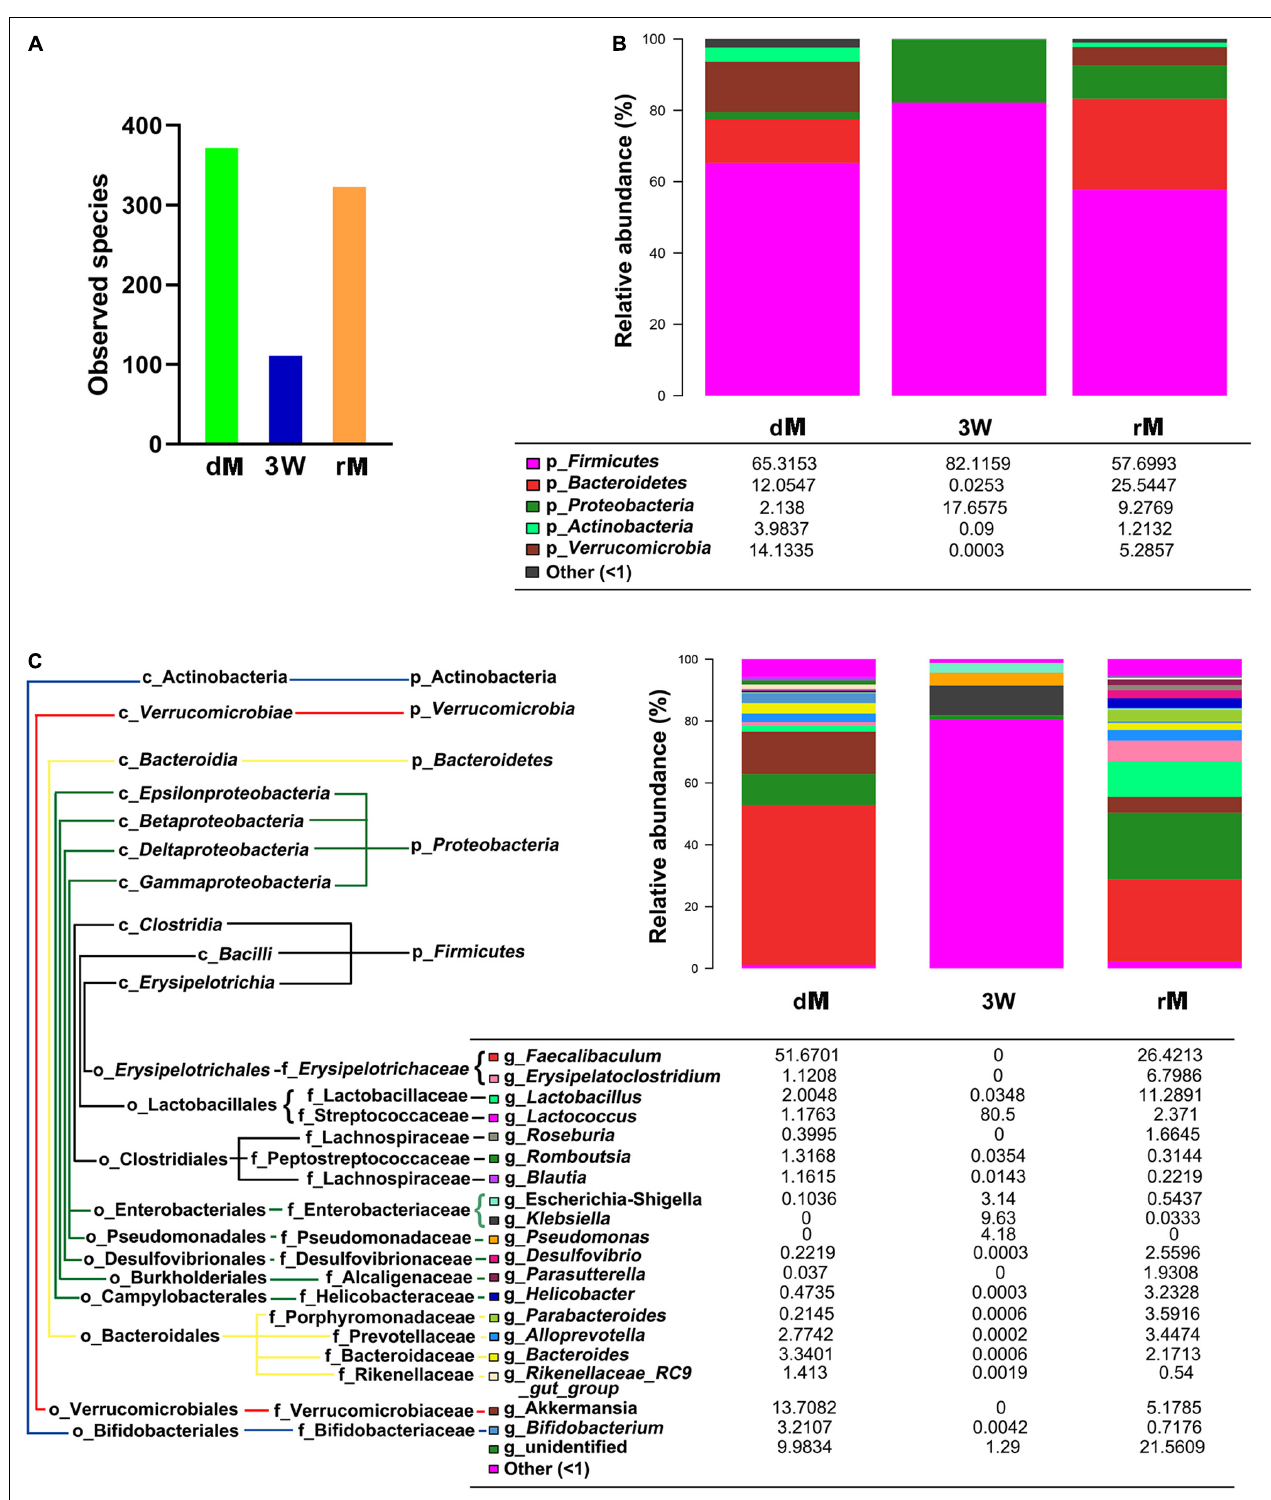
FIGURE 5 | The diversity and relative abundance of fecal microbiota after FMT. (A) Observed species of fecal microbiota among donor mice (dM), mice treated with the antibiotic cocktail for 3 weeks (3W), and receptor mice (rM). (B) Effect of FMT on the relative abundance of fecal microbiota at the phylum level. (C) Effect of FMT on the relative abundance of fecal microbiota at the genus level. dM: donor mice fed with normal diet; FMT, fecal microbiota transplantation; rM, receptor mice with FMT from dM; p_ represents microbial phylum, g_ represents microbial genus.